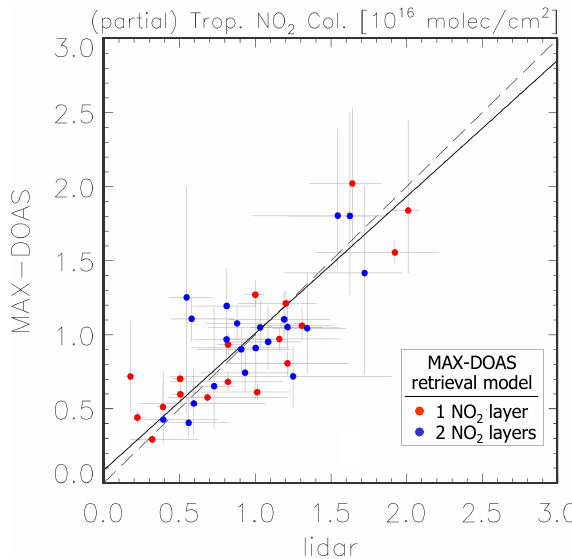
Fig. 14. Comparison of partial tropospheric NO 2 columns retrieved from lidar and MAX-DOAS at the CINDI campaign. For each lidar measurement, a choice was made which MAX-DOAS retrieval to compare with: the single (red) or double NO 2 layer retrieval (blue). This choice was based on the value of the reduced χ 2 The solid line shows a linear fit. It has a slope of 0.92 and an in- tercept of 0 . 9 × 10 15 moleccm − 2 . The two data sets have a corre- lation of 0.78 and an average difference of 0 . 1 × 10 15 moleccm − 2 ( n = 39).